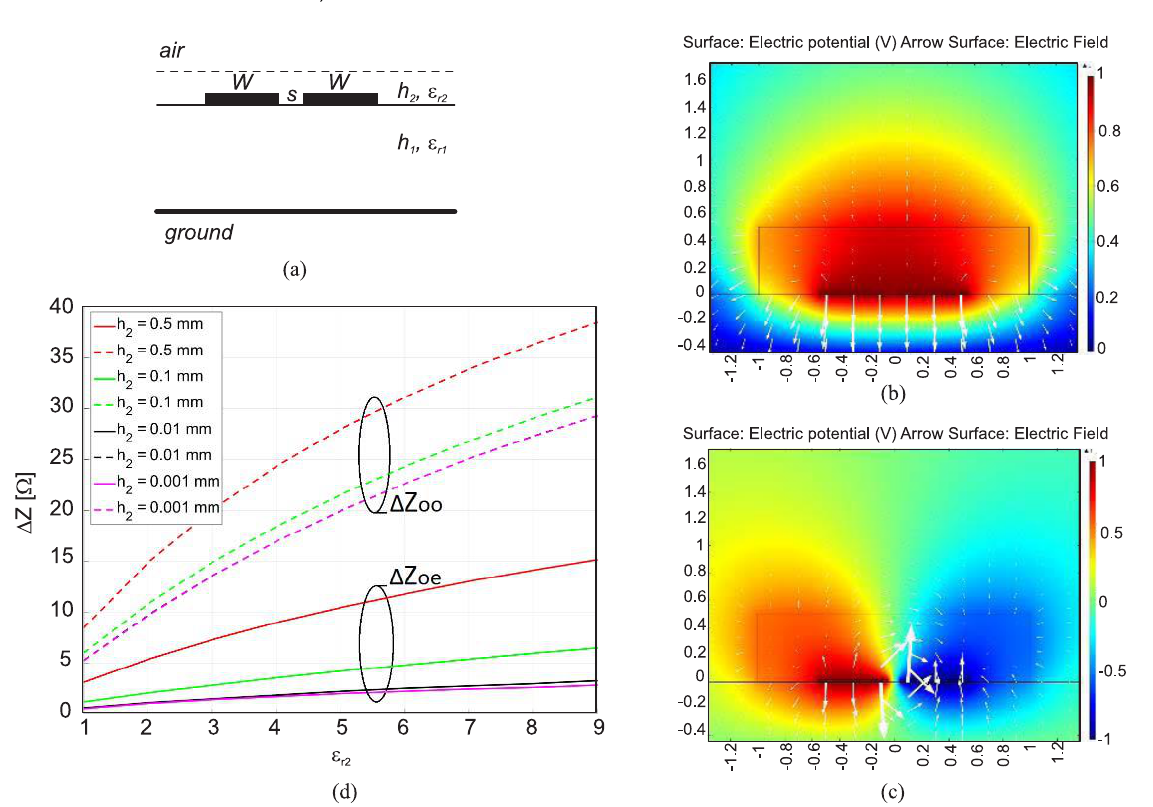
Figure 32. Microstrip line with even/odd mode fields and characteristic impedance: ( a ) a coupled line microstrip section loaded by a dielectric sample. The electric voltage (colors) and field (vectors) distribution for the even ( b ) and odd ( c ) modes. ( d ) Change of the even and odd mode characteristic impedances. Reprinted with permission from Ref.